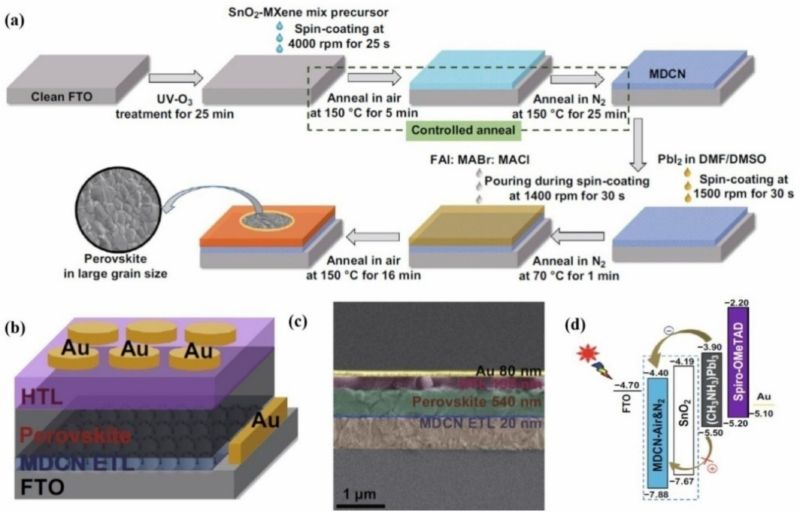
Figure 5. ( a ) Synthesis process for perovskite layer with MDCN ETL ( b ) PSC structure employing MDCN as ETL ( c ) Cross-sectional SEM image of a complete device with MDCN-0.02 ETL ( d ) Energy diagram for a working device with potential ETLs signed in the dotted box Ref.